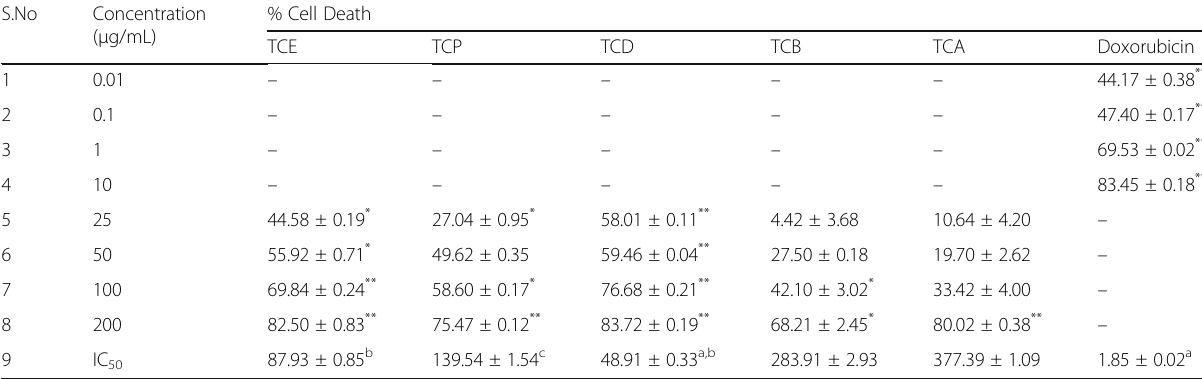
Table 4 Cytotoxicity results of T cordifolia on HeLa cell line. Cytotoxicity results of T cordifolia by SRB assay on HeLa (Human cervical carcinoma)